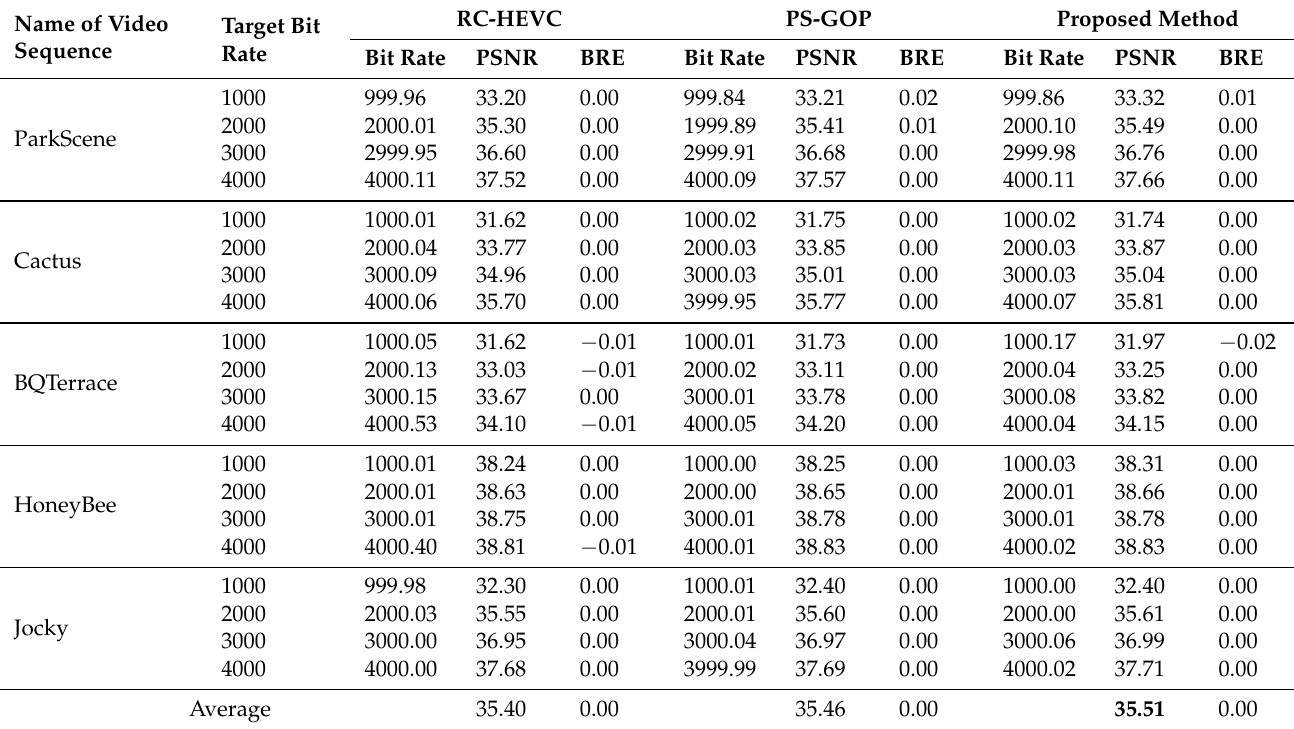
Table 5. The Performance of PSNR and BRE of Video Sequence with Resolution of 1920 × 1080 and 4k.